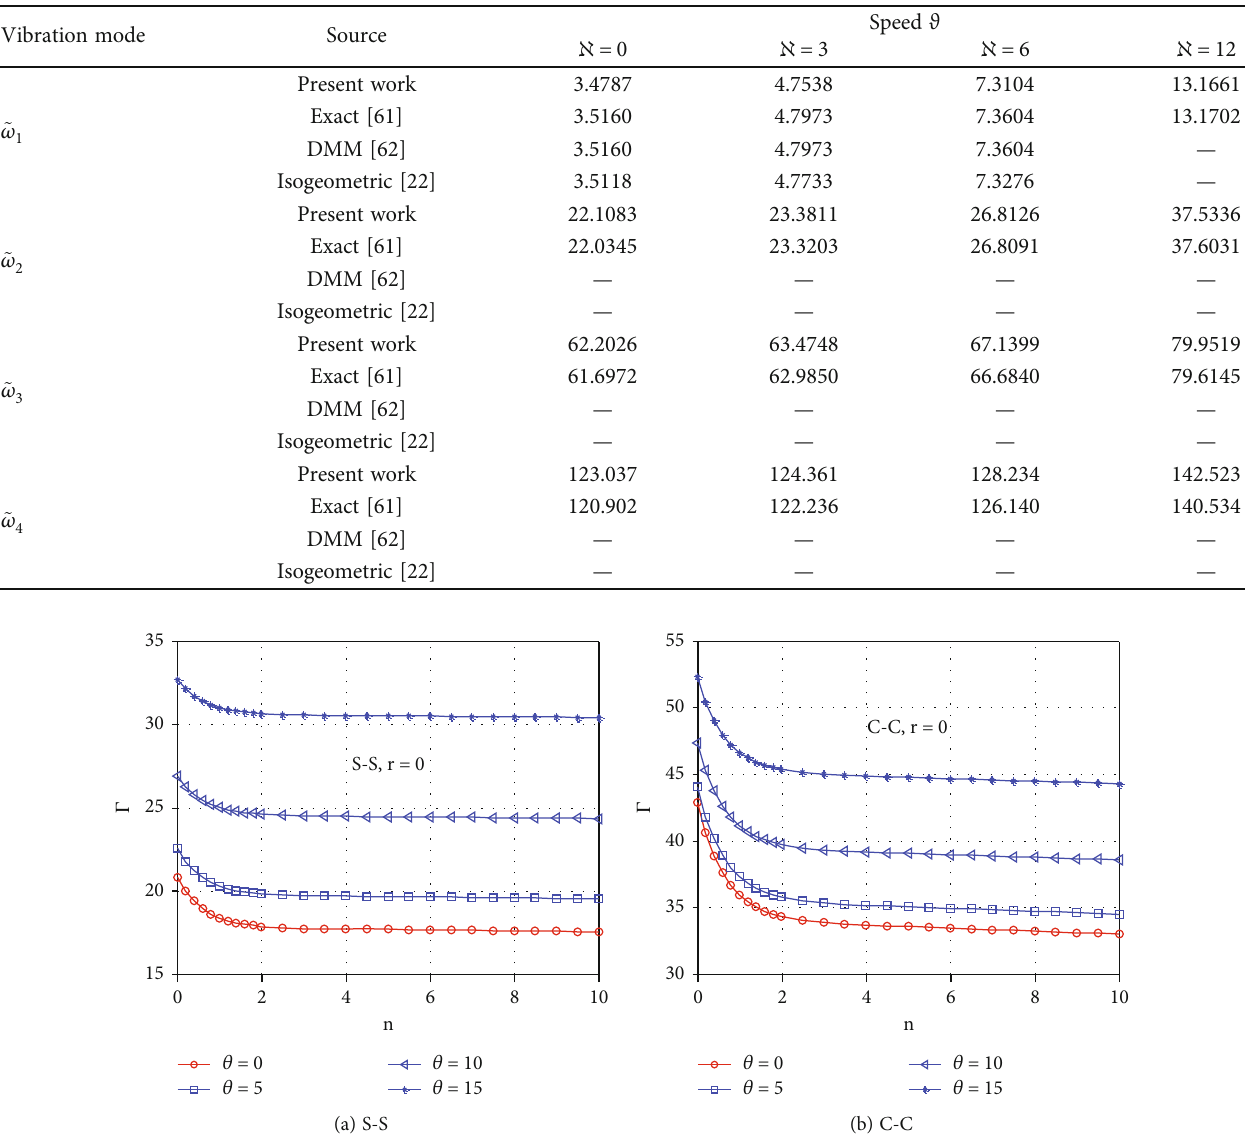
Table 3: The fi rst four nondimensional fundamental frequencies ( ℘ ) of the C-F rotating beam. Vibration mode